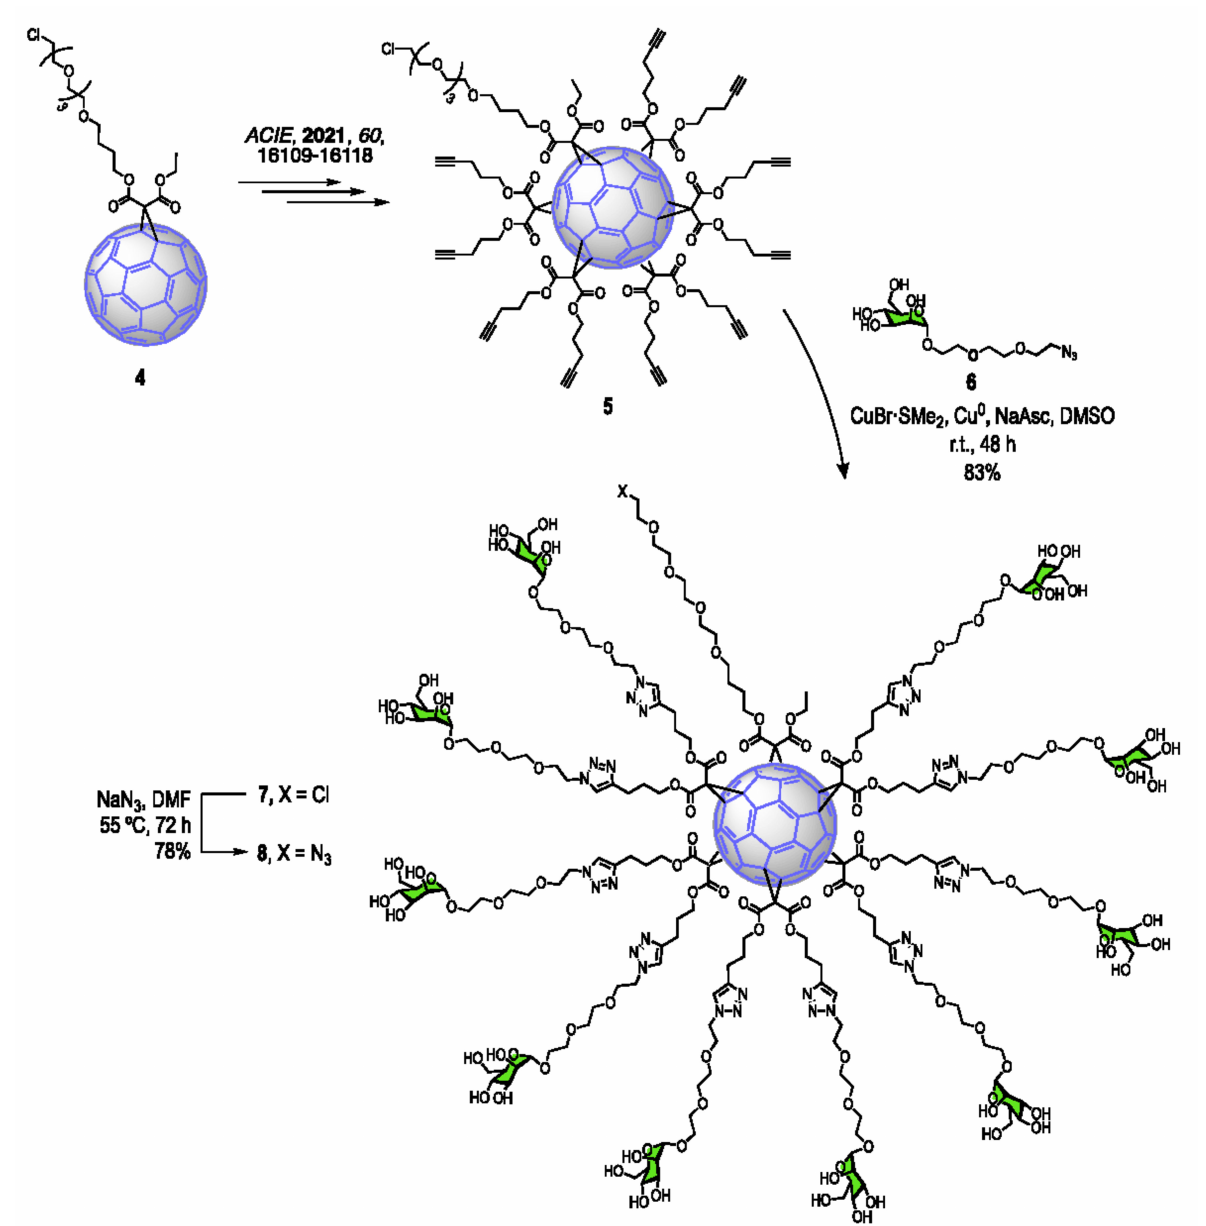
Scheme 1. Synthetic scheme for the preparation of asymmetric glycofullerene 8